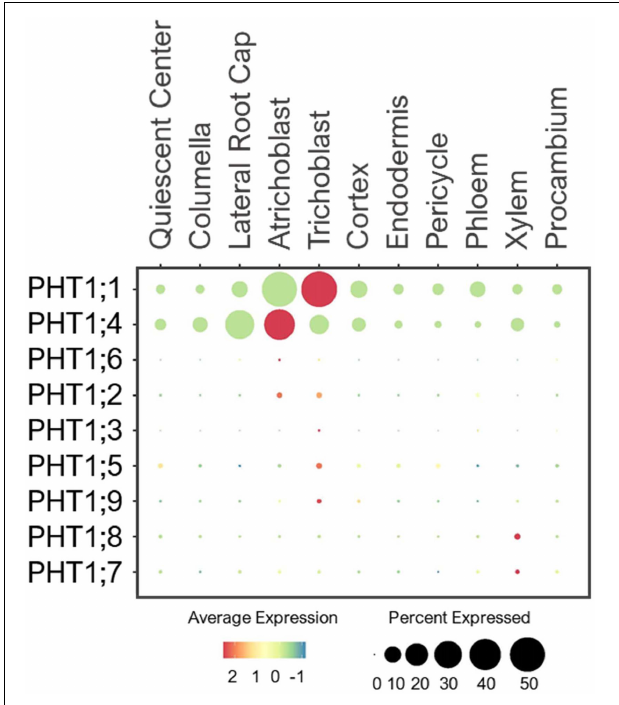
FIGURE 6 | Expression of the high-affinity PHT1 transporters in Arabidopsis root single cells. In dot plot, the circle size represents the proportion (%) of cells expressing a given gene, and the color of scale bar represents the mean expression (natural log +1